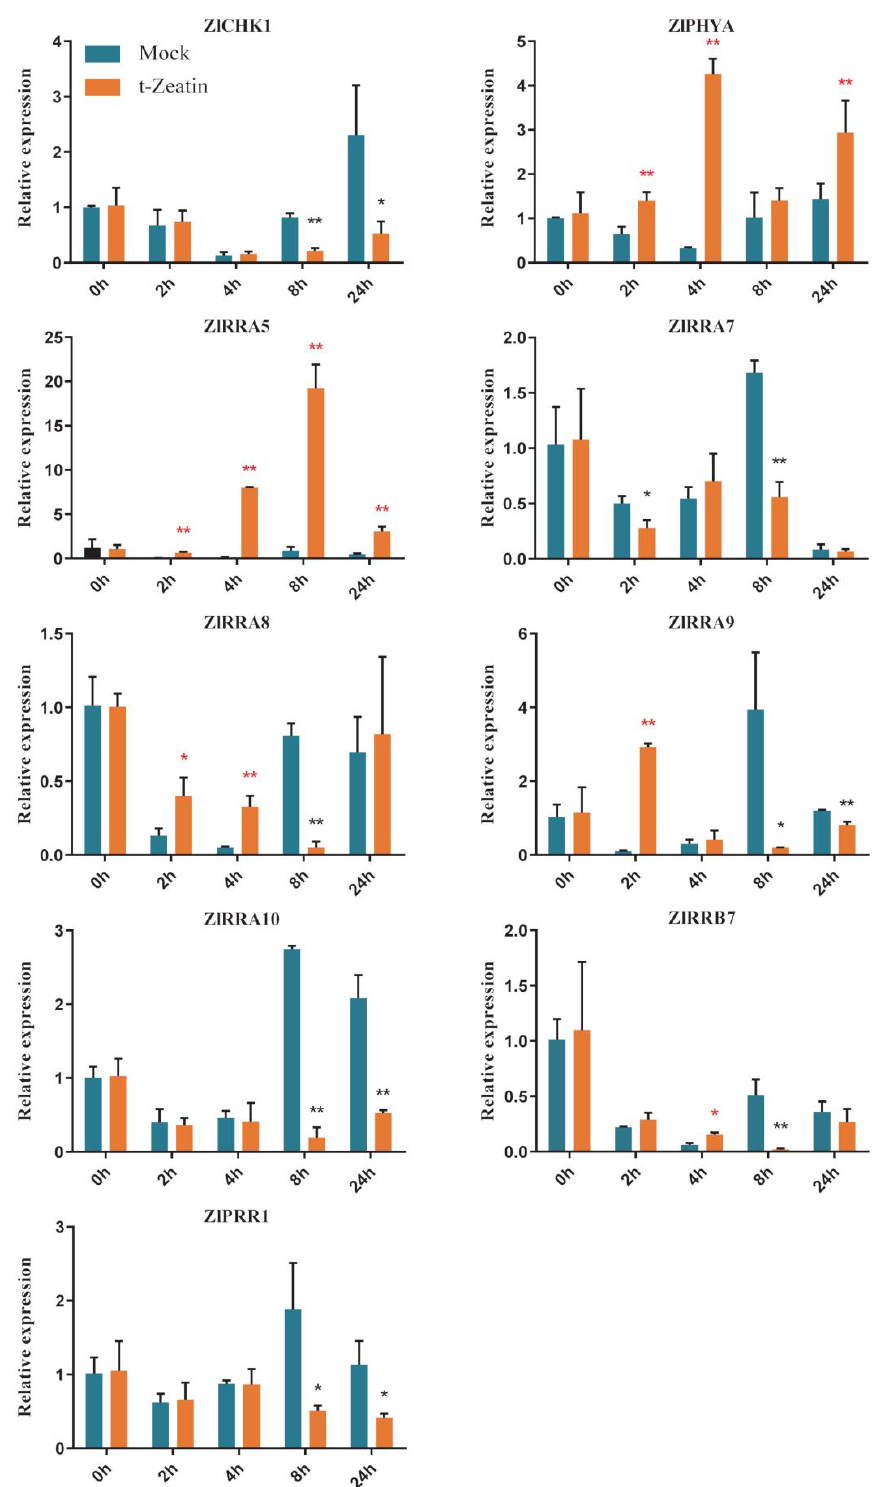
Figure 7. Expression kinetics of nine selected TCS genes in response to trans-zeatin treatment in Z. latifolia . Data are the means ± standard error ( n = 3). Two percent EtOH was used as mock treatment. * Indicates the significant di ff erences ( p < 0.05) and ** indicates significant di ff erences ( p <